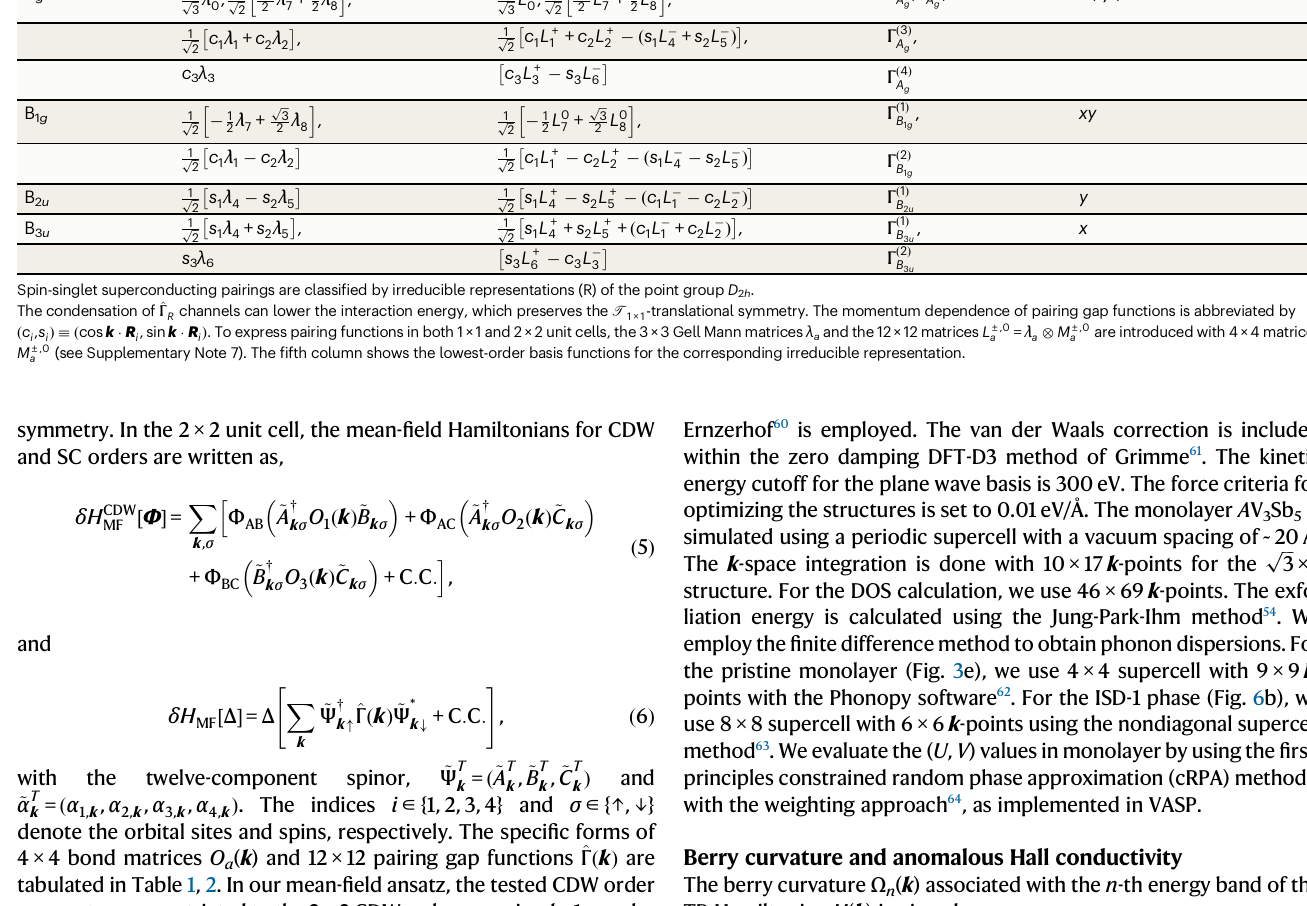
Table 2 | SC orders in the mean- fi eld analysis R Pairing in 1×1 unit cell Pairing in 2×2 unit cell ^ Γ R ð k Þ Label Basis function A g